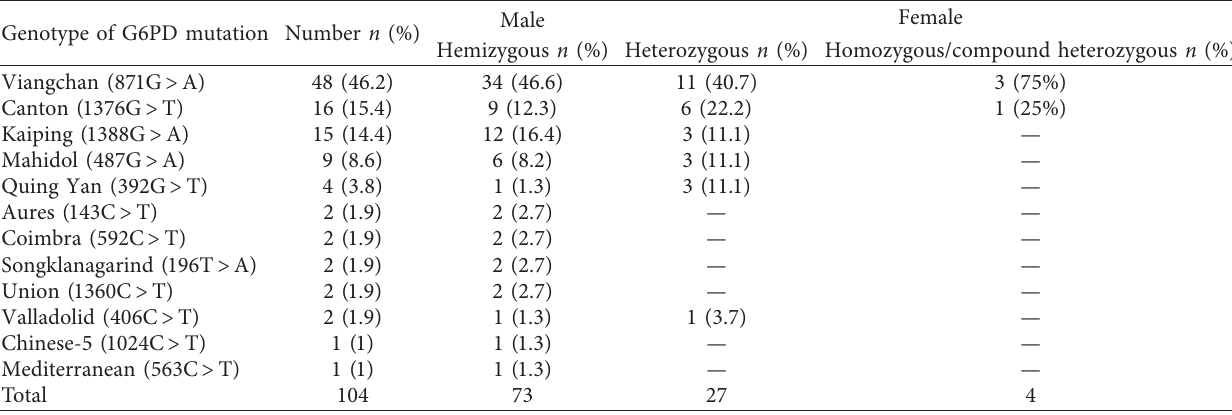
Table 2: The genotyping of 104 G6PD alleles in 102 G6PD-deficient Thai children. Genotype of G6PD mutation Number n (%)